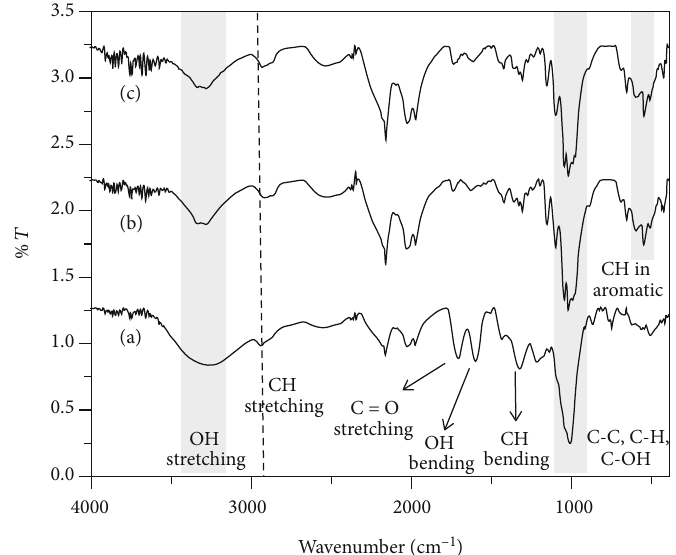
Figure 4: FTIR spectra of (a) untreated, (b) dyed, and (c) antibacterial fi nished